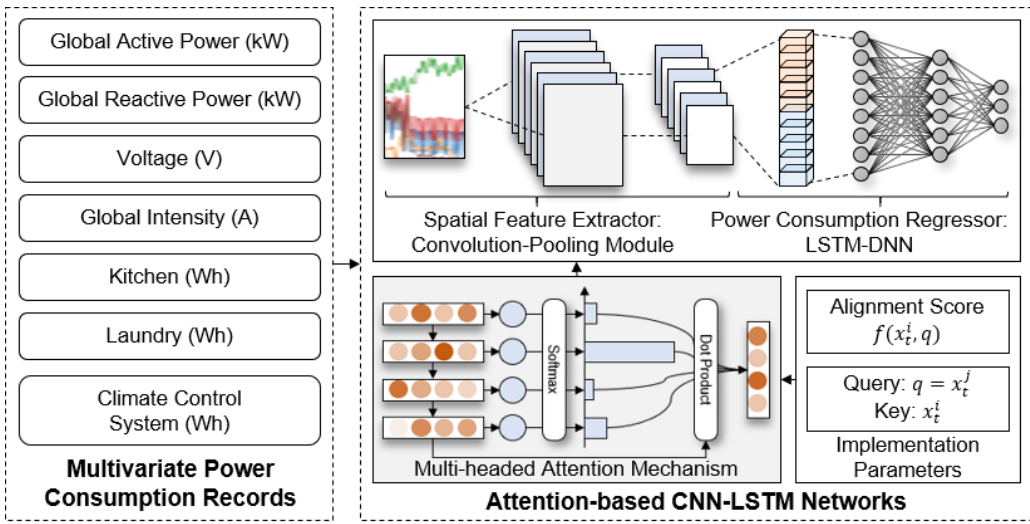
Figure 3. Overall structure of the proposed CNN-LSTM with multi-headed attention.